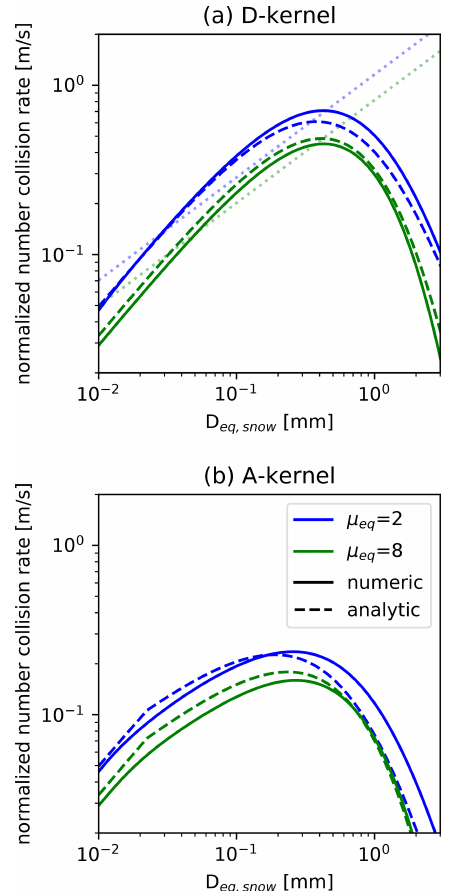
Figure B4. Numeric and analytic solution of the bulk collision rates for snow–snow (both Mix2) collisions: (a) D-kernel; (b) A-kernel.